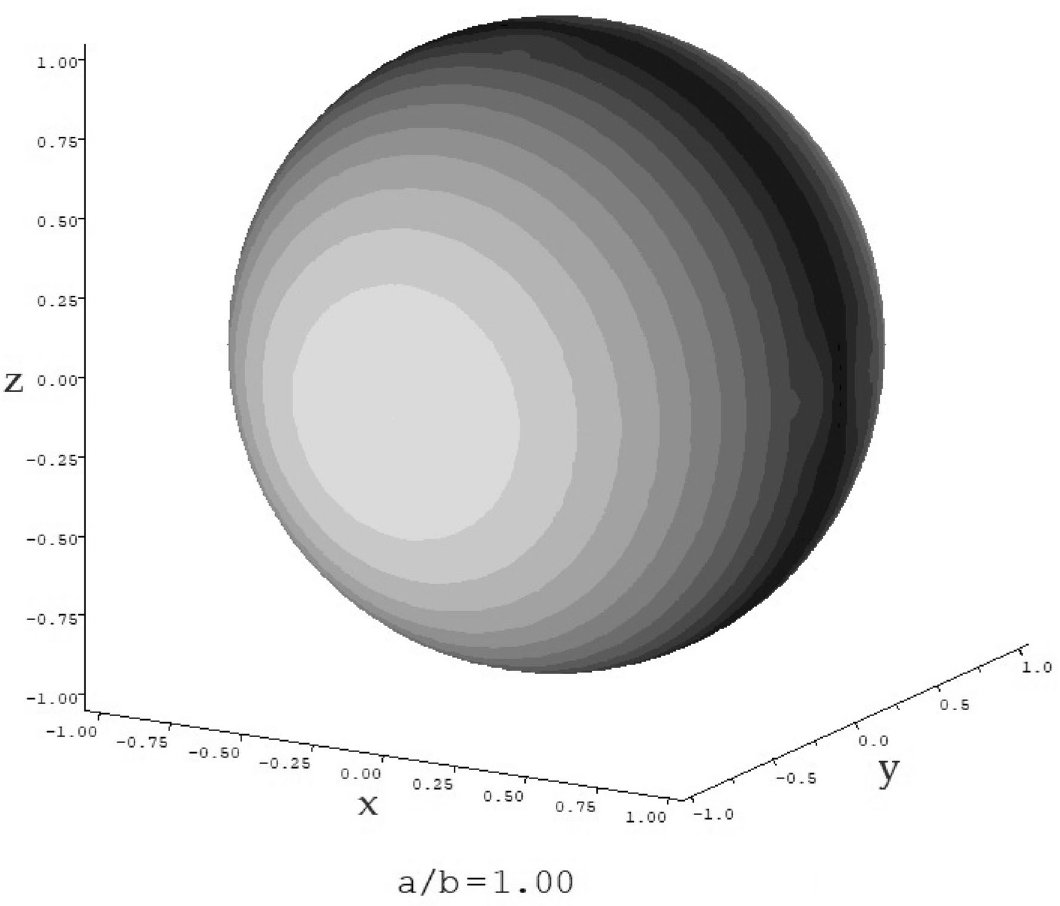
Figure 6. ELLIPS1 53 representation of the conformation of teicoplanin showing an axial ratio ( a/b ) = 1: i.e. a